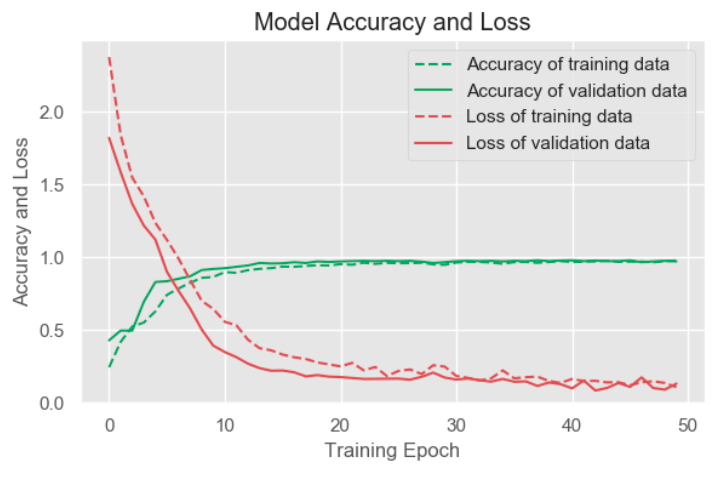
Figure 8. Loss and accuracy curves.